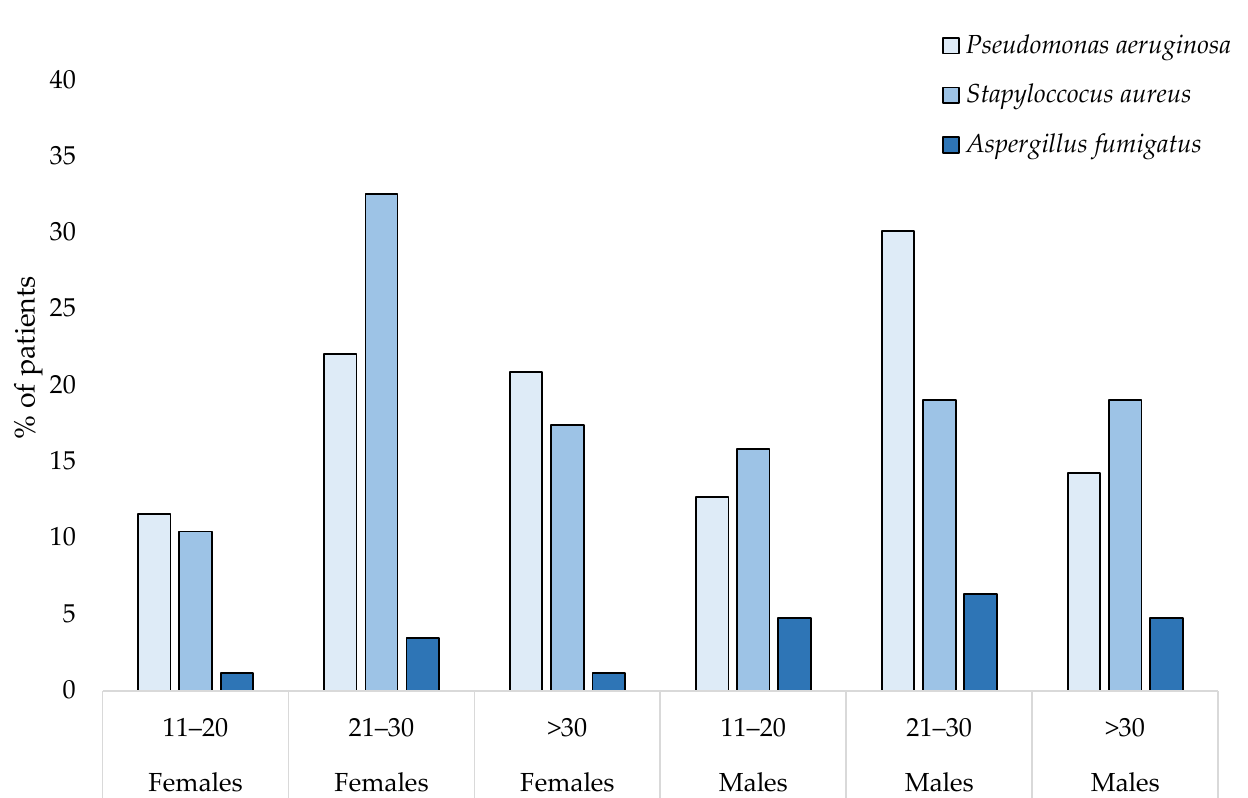
Figure 3. Percentage of chronic infections in CFRD patients by sex and age group. The most common CF mutation F508del/F508del was present in 44.9% of the CFRD patients ( n = 67). Consequently, 31.5% of patients had the F508del/other genotype, while 23.6% of participants had the other/other genotype.